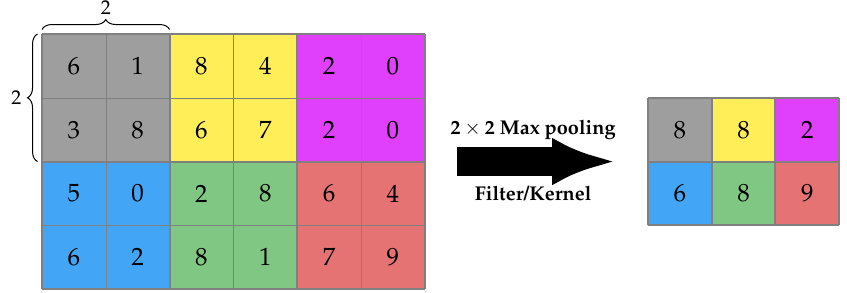
Figure 2. An example of Max pooling’s functionality